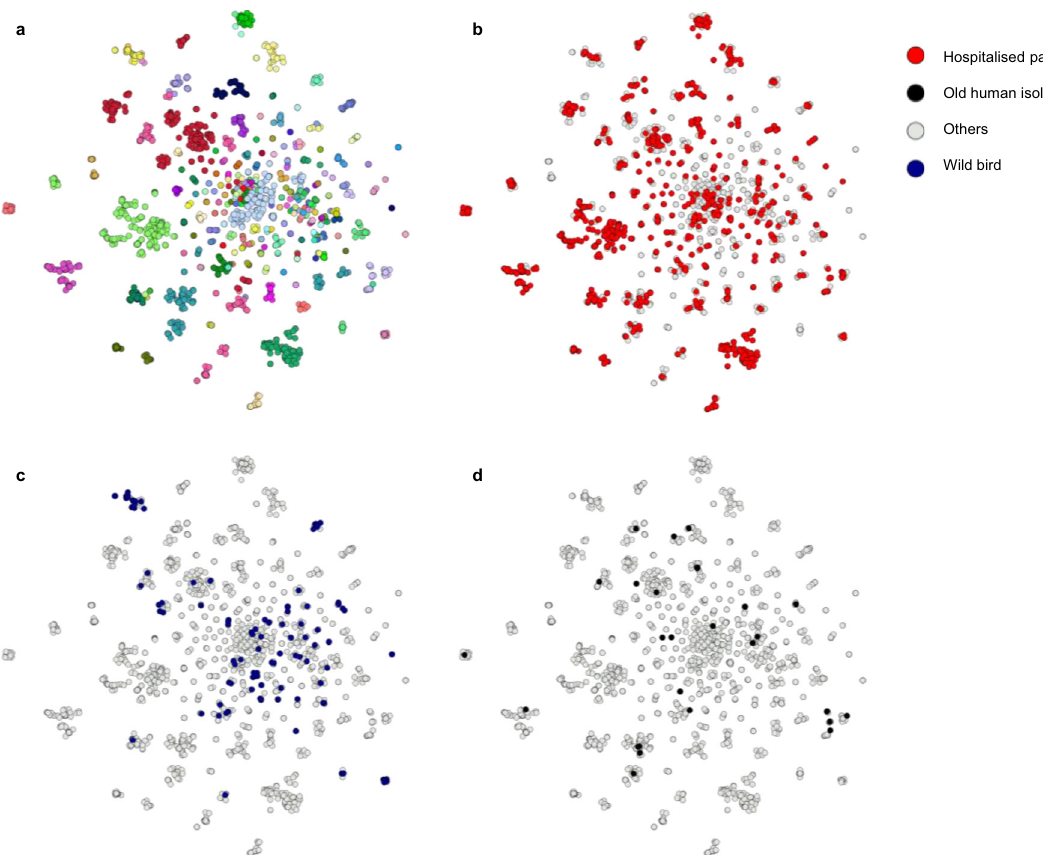
Fig. 2 Pangenome Neighbour Identi fi cation for Bacterial Populations (PANINI) 28 networks on E. faecalis pangenome depict isolates of different origins distributed across the clade structure and embedded within the same, clearly de fi ned extant clusters. a PANINI network depicts accessory clusters predominantly following the designated Population Partitioning Using Nucleotide K-mers (PopPUNK; PP) 19 clustering, with each node representing a single isolate ( n = 2027), each group of attached nodes largely representing a PANINI cluster ( n = 70), and each colour indicating a separate PP cluster ( n = 173). b Hospitalised patient isolates shown in red and other isolation sources in grey. c Wild bird isolates shown in dark blue and other isolation sources in grey. d Old isolates of human origin shown in black and other isolation sources in grey. The illustration was created using Microreact 77 . Source data are provided as a Source Data fi